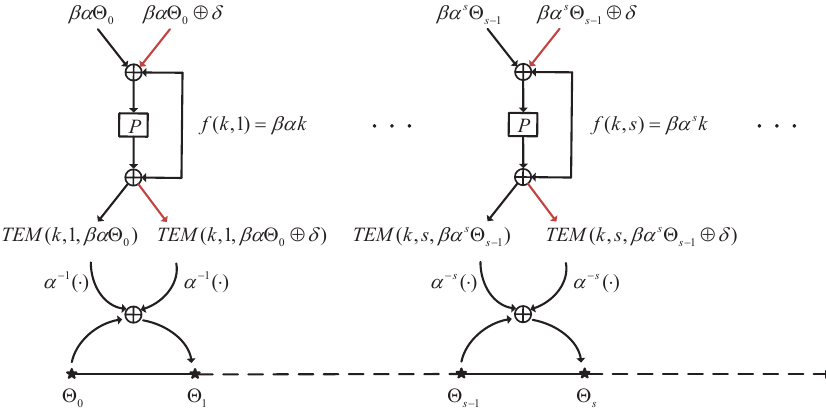
Figure 2: The Procedure of constructing two points, Θ 1 and Θ s , on an on-line chain